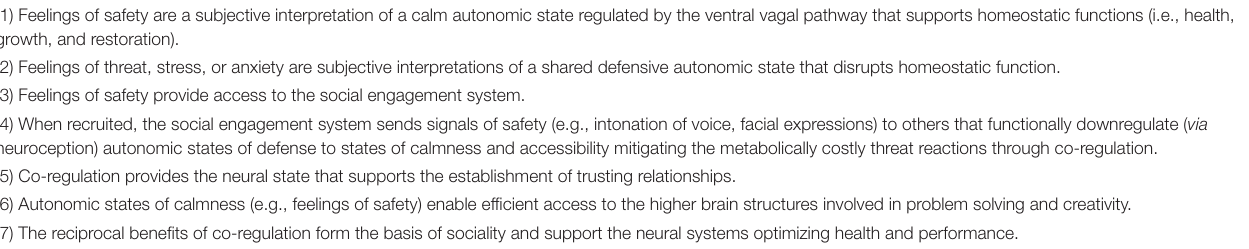
TABLE 2 | Principles of a science of